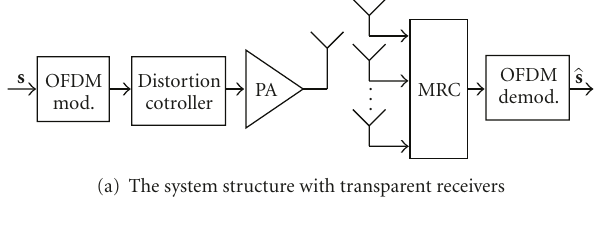
OFDM demod.Receiver-side